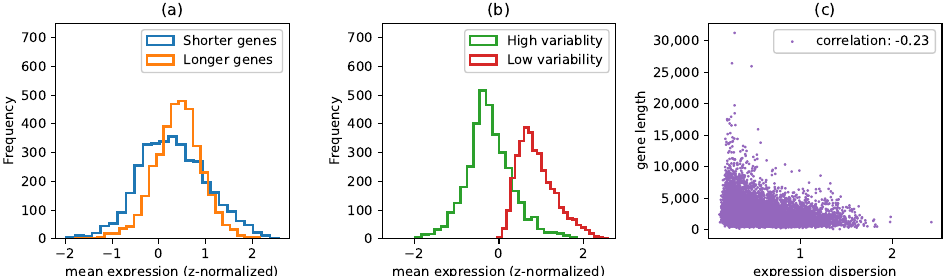
Figure 3. ( a ) Mean expression levels of genes with length above 75th percentile (long genes), and genes with length below 25th percentile (short genes). Long genes are highly expressed compared to short genes. ( b ) Mean expression levels of genes with expression dispersion above 75th percentile, and genes with dispersion below 25th percentile. Low dispersion genes are highly expressed compared to high dispersion genes. ( c ) Gene length vs. expression